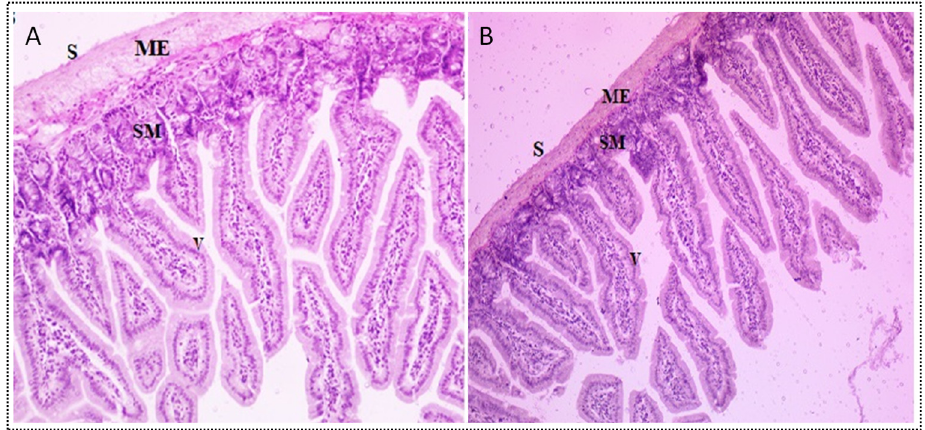
Figure 12. Histopathology image: ( A ) intestine section of normal albino rat, ( B ) showing: Serosa (S), muscularis externa (ME), submucosa (SM) with numerous eosinophilic granule-containing cells (rectangle), and mucosa (M) with epithelial layer and villi (V).